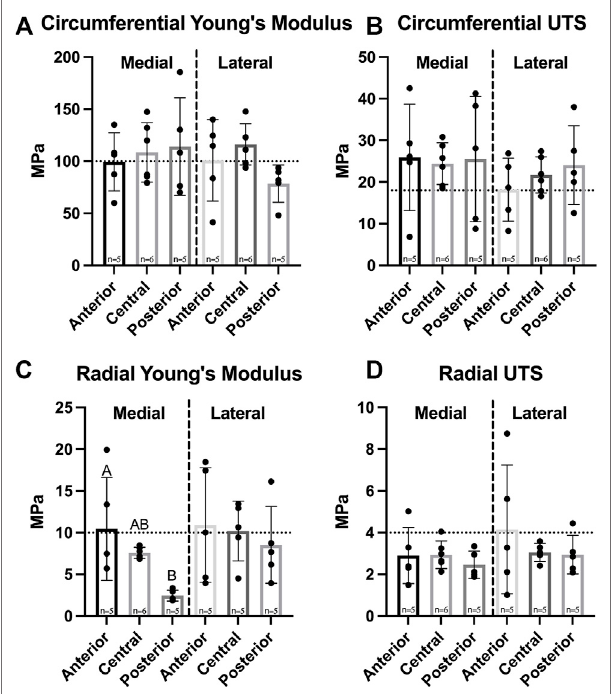
FIGURE 5 | Compressive properties of Yucatan minipig knee menisci. (A – D) Aggregate modulus, permeability, shear modulus, and Poisson ’ s ratio are shown for medial and lateral menisci, respectively. Student ’ s t -test showed a signi fi cant difference between medial and lateral menisci in permeability values. One-factor ANOVA showed no signi fi cant differences in any compressive property among regions of the same meniscus. All data are presentedasmeans±standarddeviations.Statisticalsigni fi canceisindicated by bars not sharing the same letters within the same meniscus; additionally, horizontal dotted lines on the Y-axis represent human meniscus values from the literature for comparison totheminipig (Sweigartet al.,2004; Makris et al., 2011; Morejon et al.,